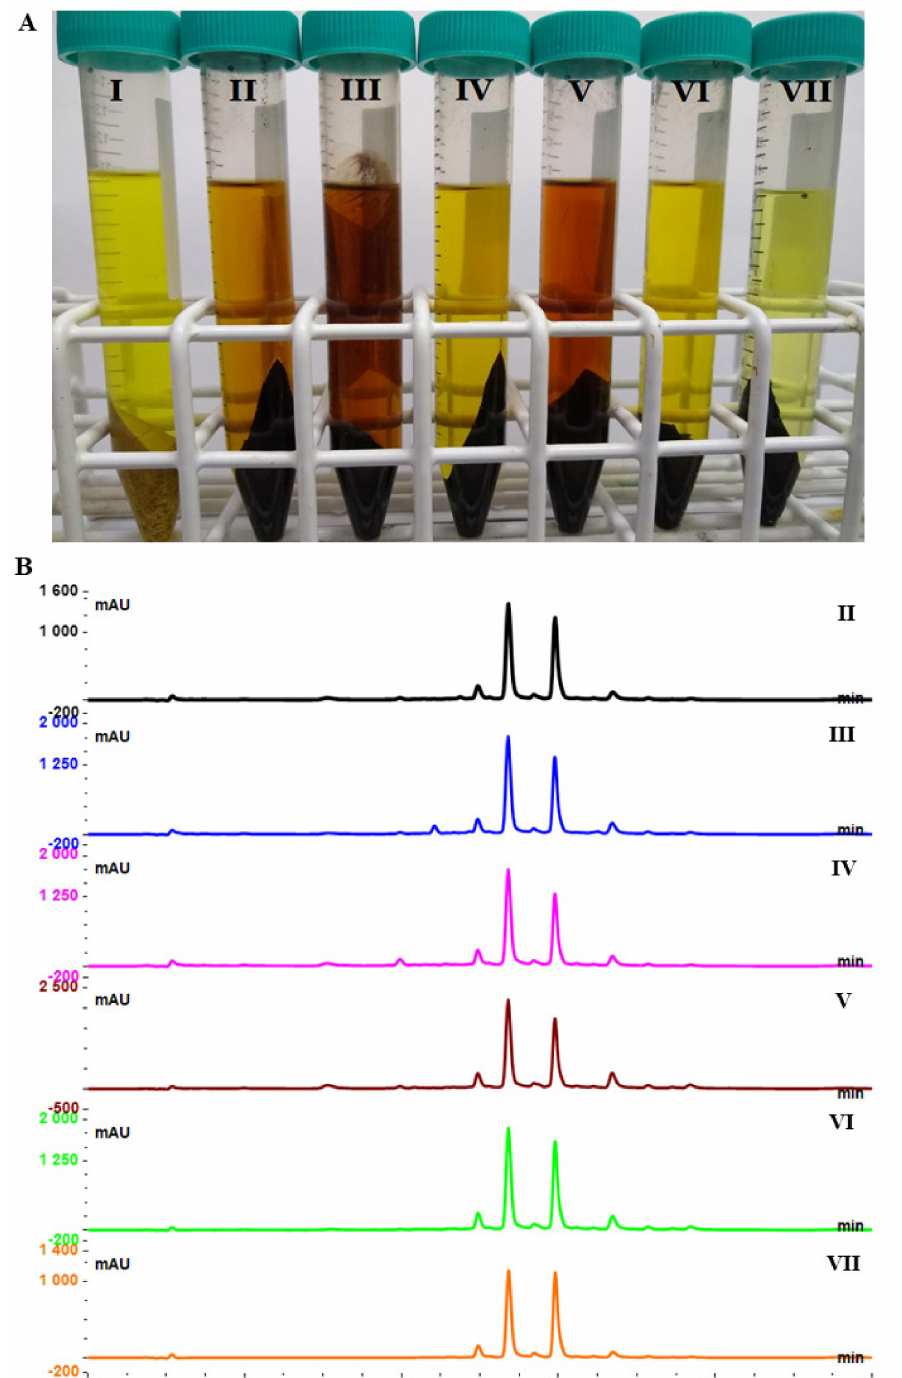
Figure 4. ( A ): Metanolic extract of dry root (I), and extracts of root after hydrolysis in ethanol (II), methanol (III), 2-propanol (IV), acetone (V), ethyl acetete (VI) and diethyl ether (VII). ( B ): UHPLC chromatograms of samples obtained after extraction of the reaction mixture obtained after acidic hydrolysis of baikal skullcap root by a particular